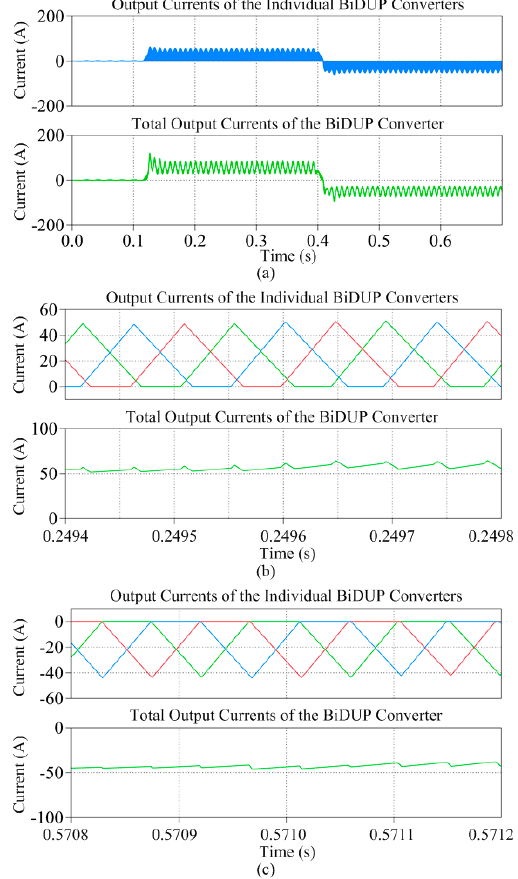
Figure 9. The current waveforms within the BiDUP converters under the worst-case load scenario ( i d * = 0 A from 0 to 0.12 s, i d * = 118 A from 0.12 to 0.4 s, and i d * = − 118 A from 0.4 to 0.7 s); ( a ) The overall output current, ( b ) enlarged waveform during consuming period, and ( c ) generating period.